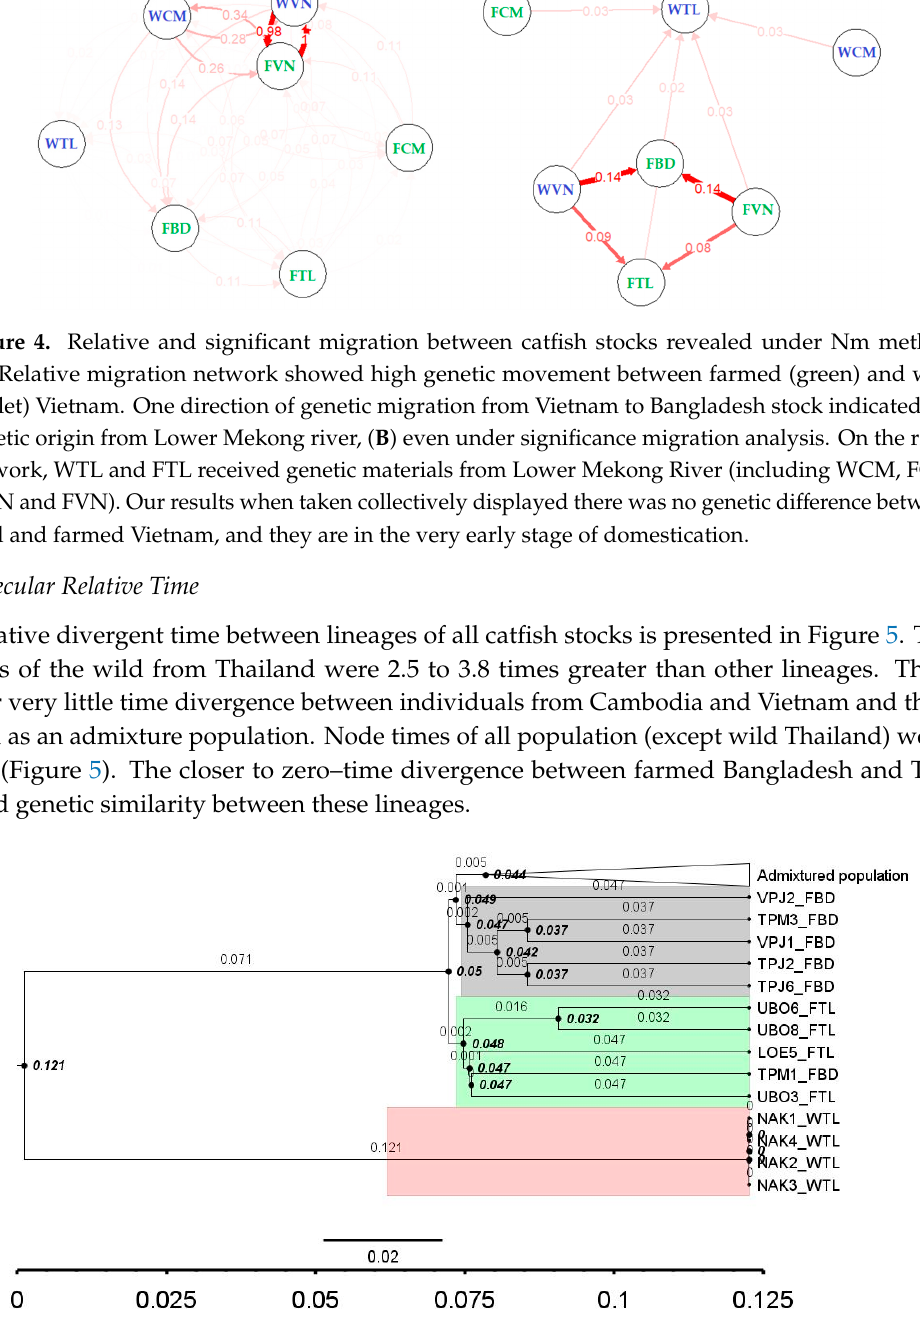
Table 4. Effective population size over catfish stocks for farm vs wild fish, country and region levels.